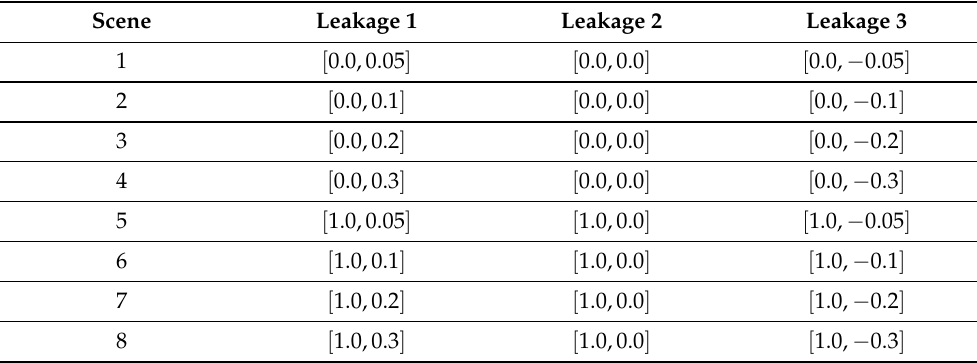
Table 1. Leakage positions (m) of three crowded